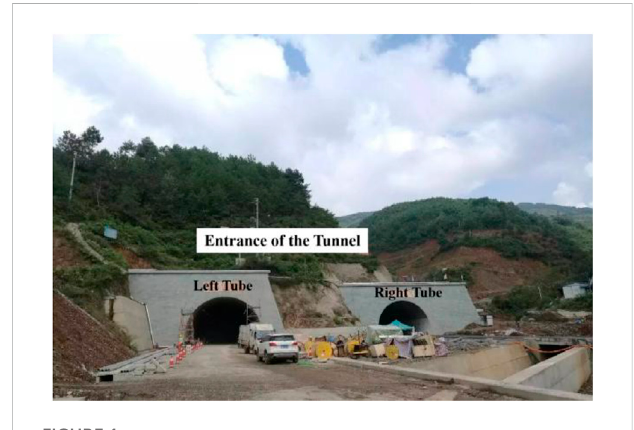
FIGURE 1 Terrain of the tunnel entrance section.